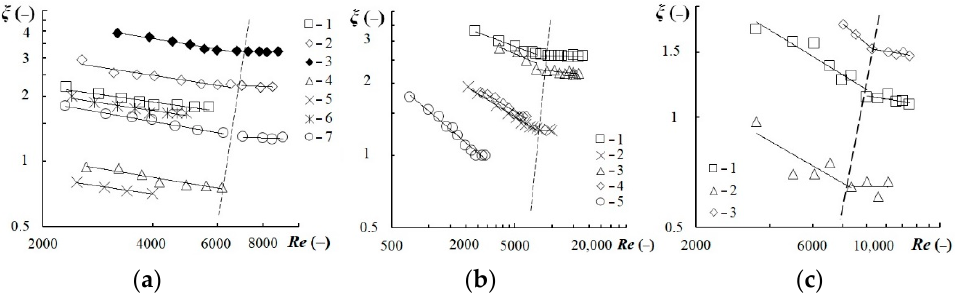
Figure 5 allowed two typical gas flow areas to be identified: the turbulent and self-pressing flows separated by a dashed line.